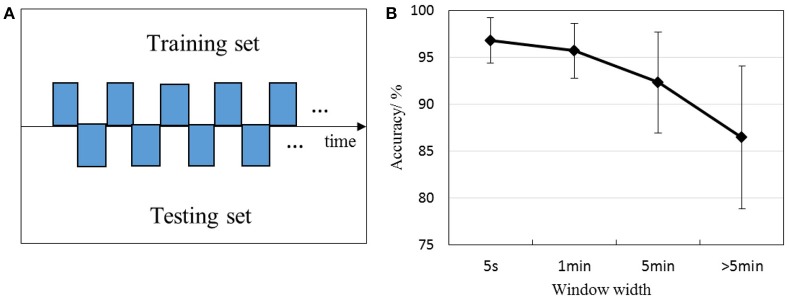
Classification rates with different window width. For example, 1 min represents the first 12 samples were sent to the training set, and the next 12 samples to the testing set in sequence, then the third 12 samples were to the training set. (A) Illustrates the sample partitioning method with a certain particular window width, (B) depicts the performance with different window width.